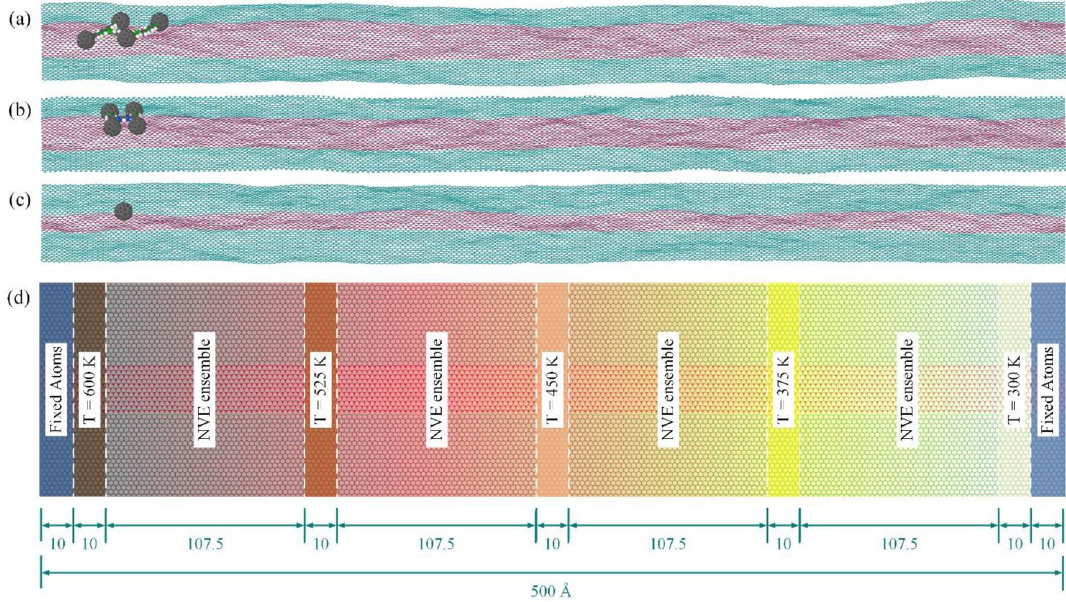
Figure 7. The simulation setup of ( a ) nanocar, ( b ) nanotruck, and ( c ) C 60 on the nanoroad exposed to the thermal gradient. ( d ) Schematic view of the simulation setup, used to create a suitable thermal gradient along the